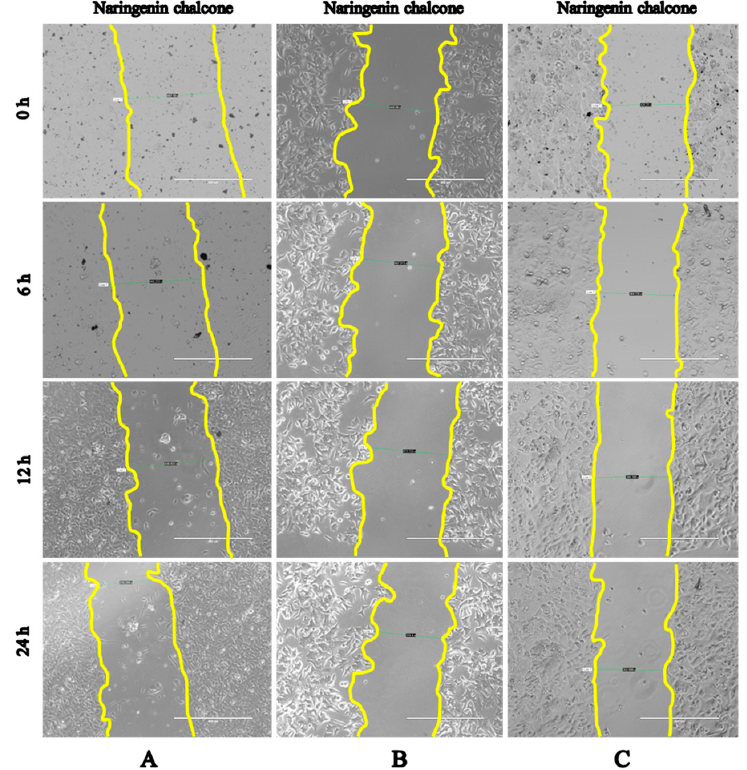
Figure 5. The effect of naringenin chalcone on all three cell lines in the scratch test: ( A ) for PNT1A cells; ( B ) for 22RV1 cells; and ( C ) for PC3 cells. Table 1. Results of the scratch test for PNT1A cells.